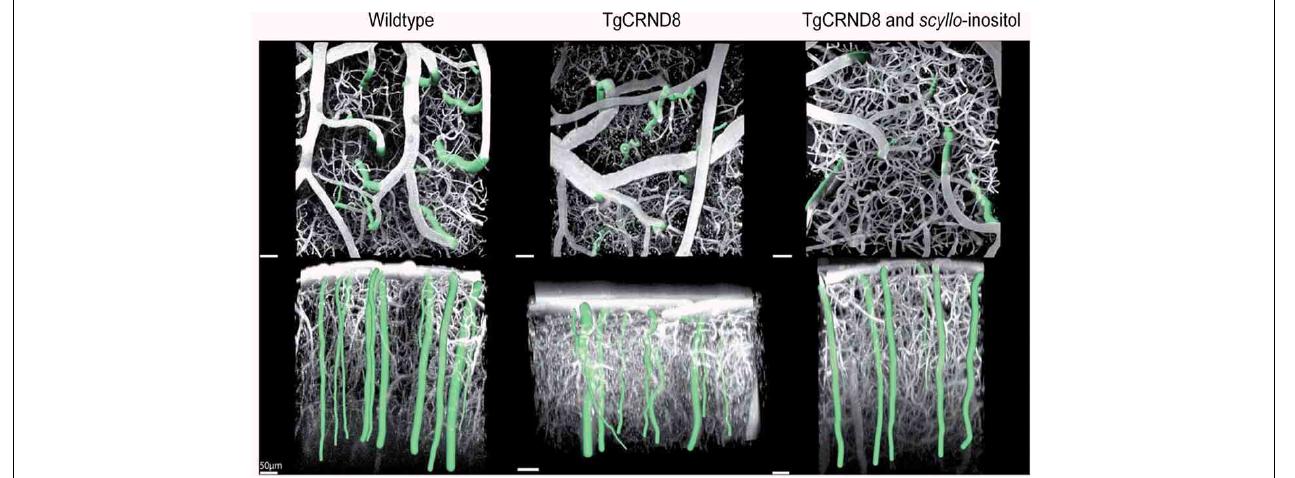
FIGURE 10 | Segmentation of cortical penetrating vessels overlaid on maximum intensity projections of cortical microvasculature obtained from in vivo two-photon fluorescence microscopy images of the cortical microcirculation of 6.5–12-month-old mice: parallel to cortical surface (top row) and perpendicular to cortical surface (bottom row). Penetrating